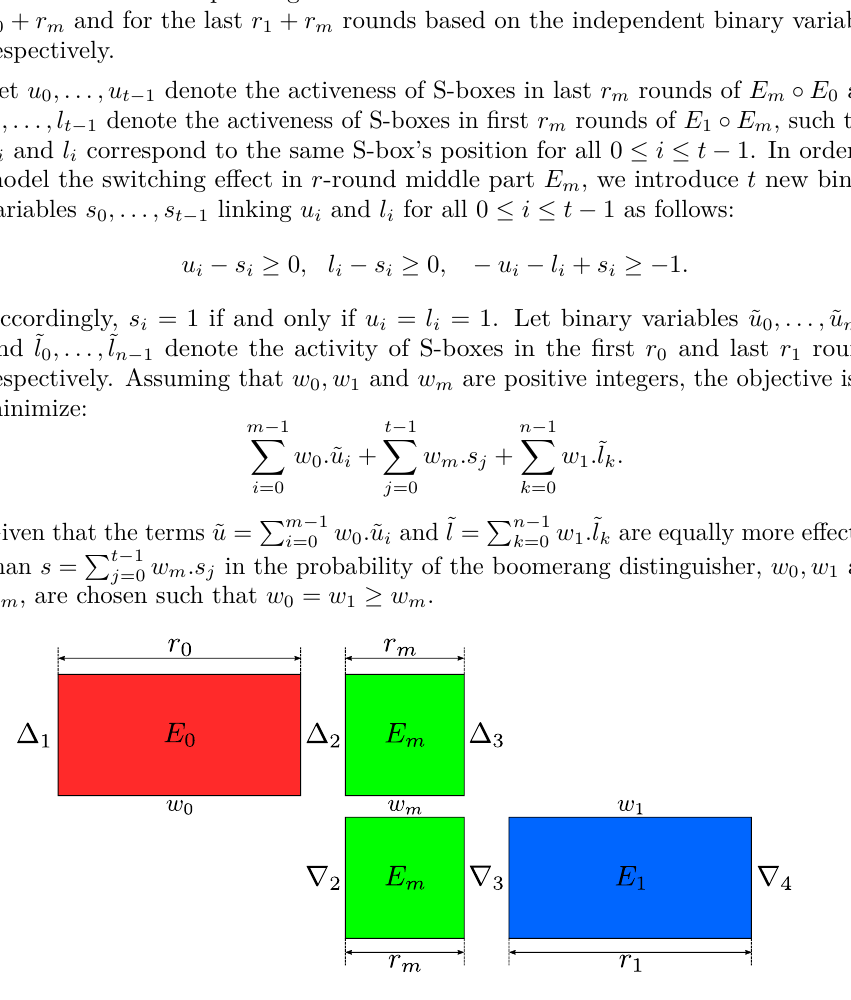
Figure 5: Main parameters of our word-oriented MILP tool to search for boomerang